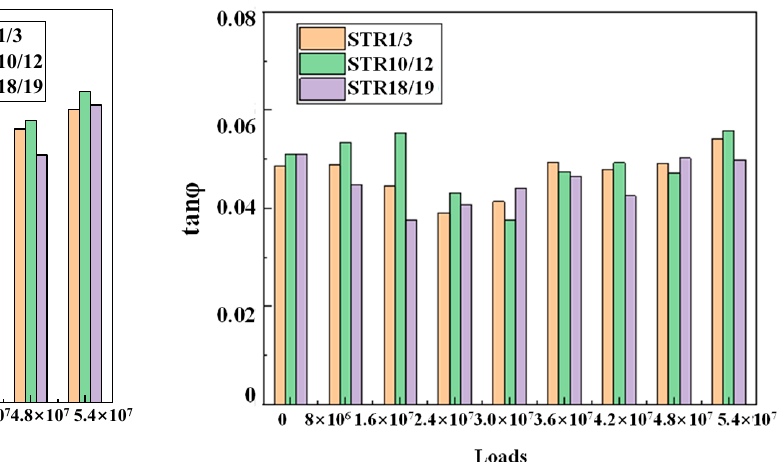
Figure 12. Complex modulus and phase angle at − 20 °C for different loading cycles.